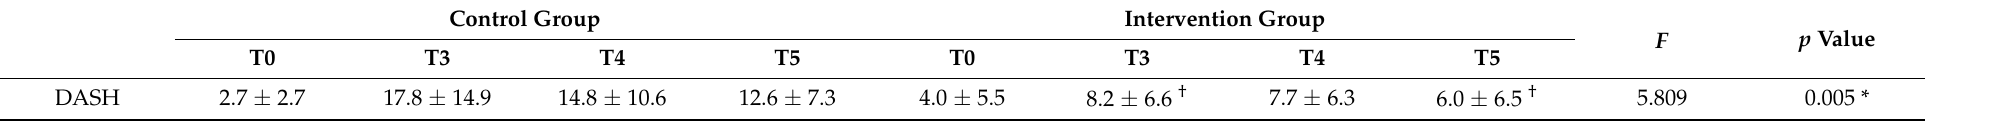
Table 3. The values in disabilities of the arm, shoulder, and hand questionnaire (DASH score). Control Group